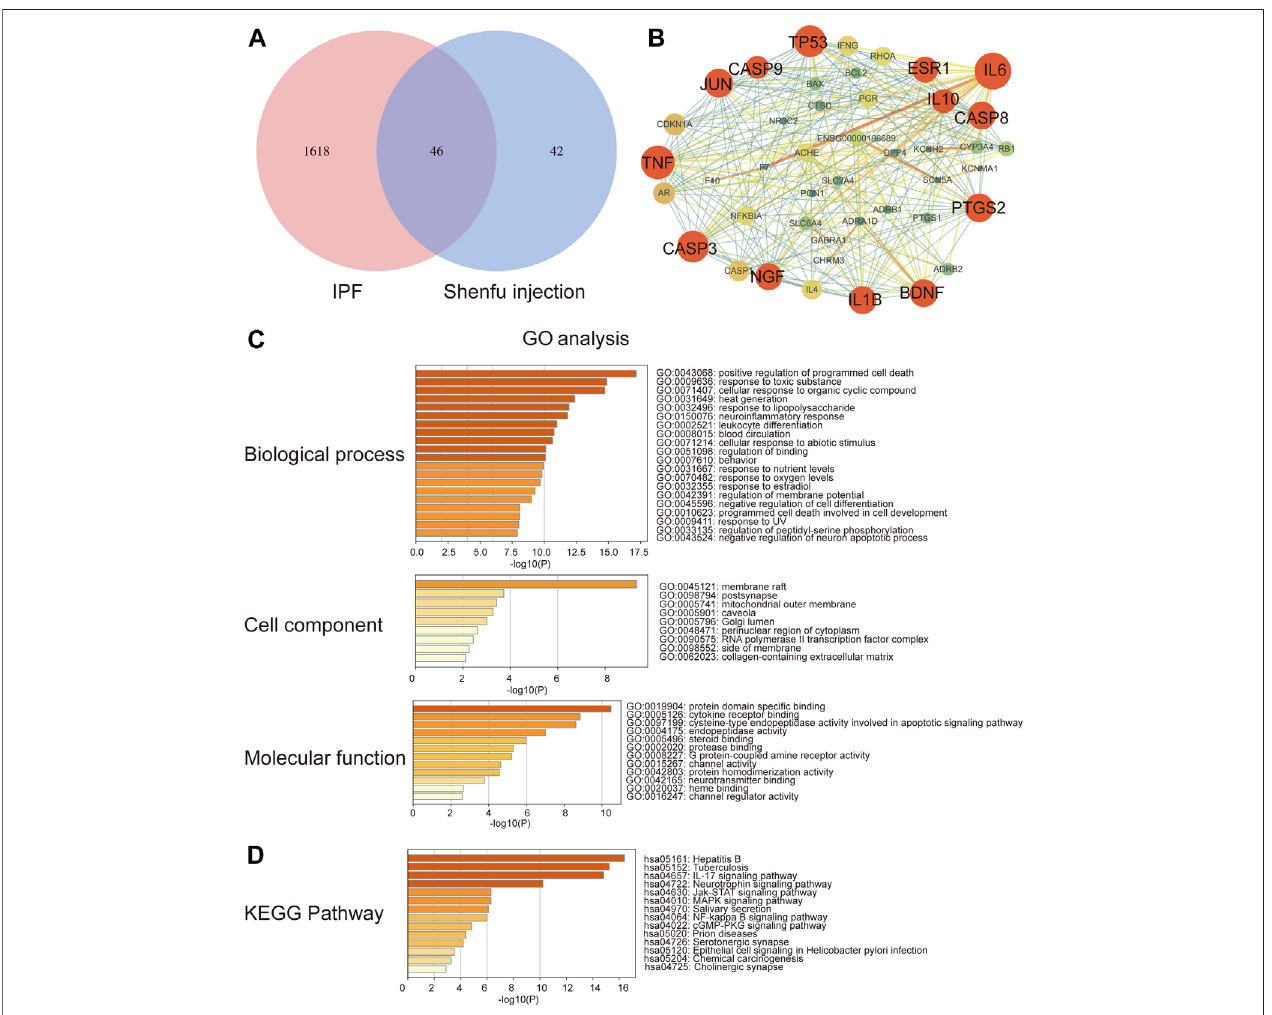
FIGURE 1 | Network pharmacology analysis of Shenfu injection and IPF. (A) The intersection of targeted genes between Shenfu injection and IPF shown as Venn diagram. (B) The PPI network analysis: the node represents the protein and the edge represents the connection between proteins; the size of the node represents the importance of the gene in the network. (C) GO enrichment analysis of potential targets genes including biological process, cellular components and molecular function. (D) KEGG pathway enrichment analysis of the top 14 pathways.